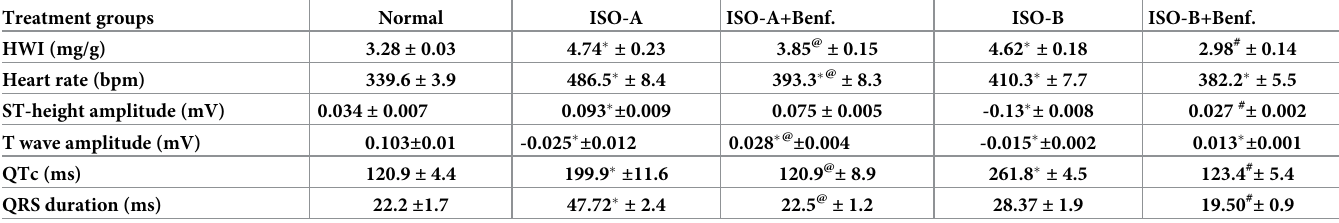
Table 1. Effect of benfotiamine pre- and post-treatments on HWI and ECG changes in ISO-induced MI in rats. Treatment groups